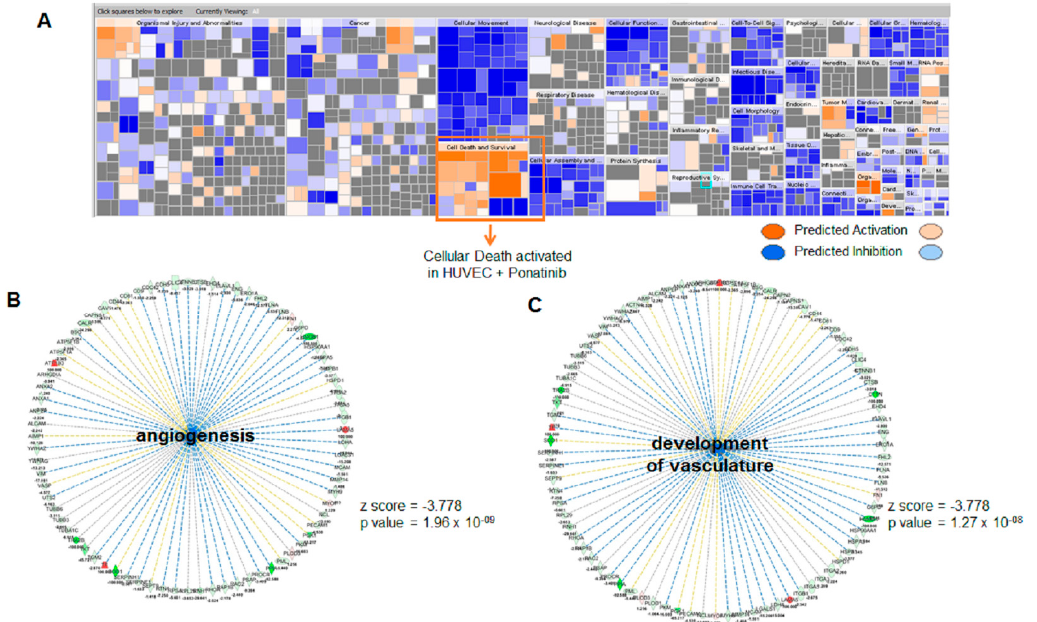
Figure 2. Comparative proteomic analysis of endothelial cells exposed to ponatinib and Notch-1 signaling inhibition. Panel ( A ), Functions and diseases categories activated and / or inhibited in human umbilical endothelial cells (HUVECs) treated with ponatinib compared to those co-treated with ponatinib and anti-Nothch-1 antibody are shown as a heatmap visualization, in which orange and blue shapes represent predicted activation or inhibition, respectively. IPA generates a parameter (z-score) that is able to perform a consistent prediction for activation or inhibition of such categories with statistical significance. In particular, z-scores > 2.0 indicate that a molecule and / or function is activated, whereas z-scores < − 2.0 indicate the inhibition of target. Panels ( B , C ), downstream network analysis of the proteins from HUVECs exposed to ponatinib. Images show “angiogenesis” ( B ) and “vascular development” ( C ) categories predicted to be inhibited by the proteins from HUVECs treated with ponatinib. For both functions, the p value and z-score are